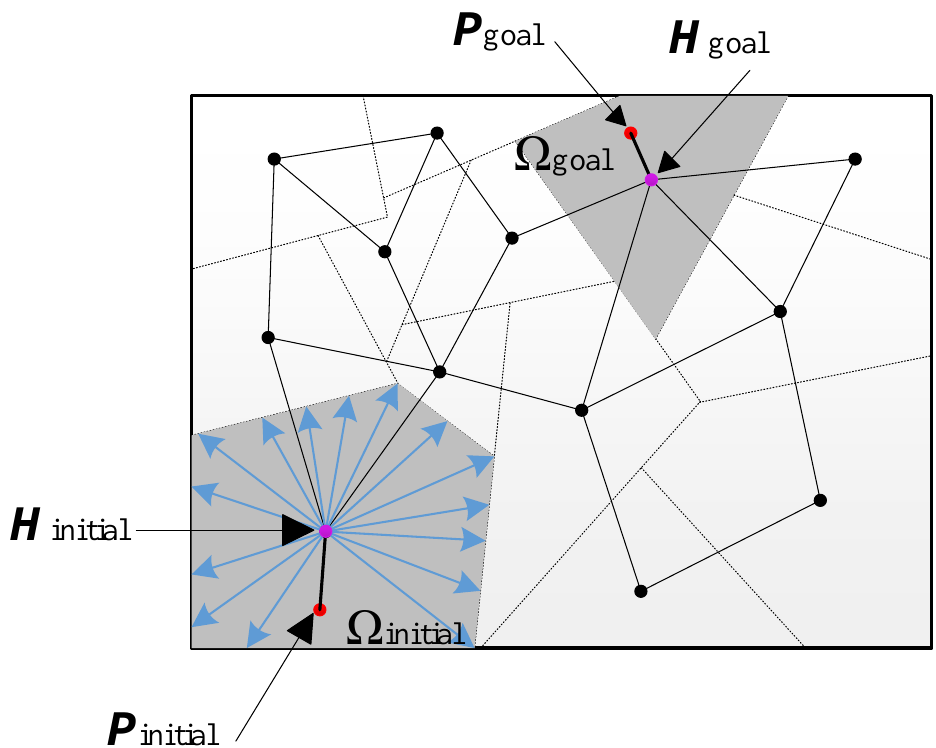
Figure 2. Schematic diagram of the joint space path planning from P initial - to P goal -based